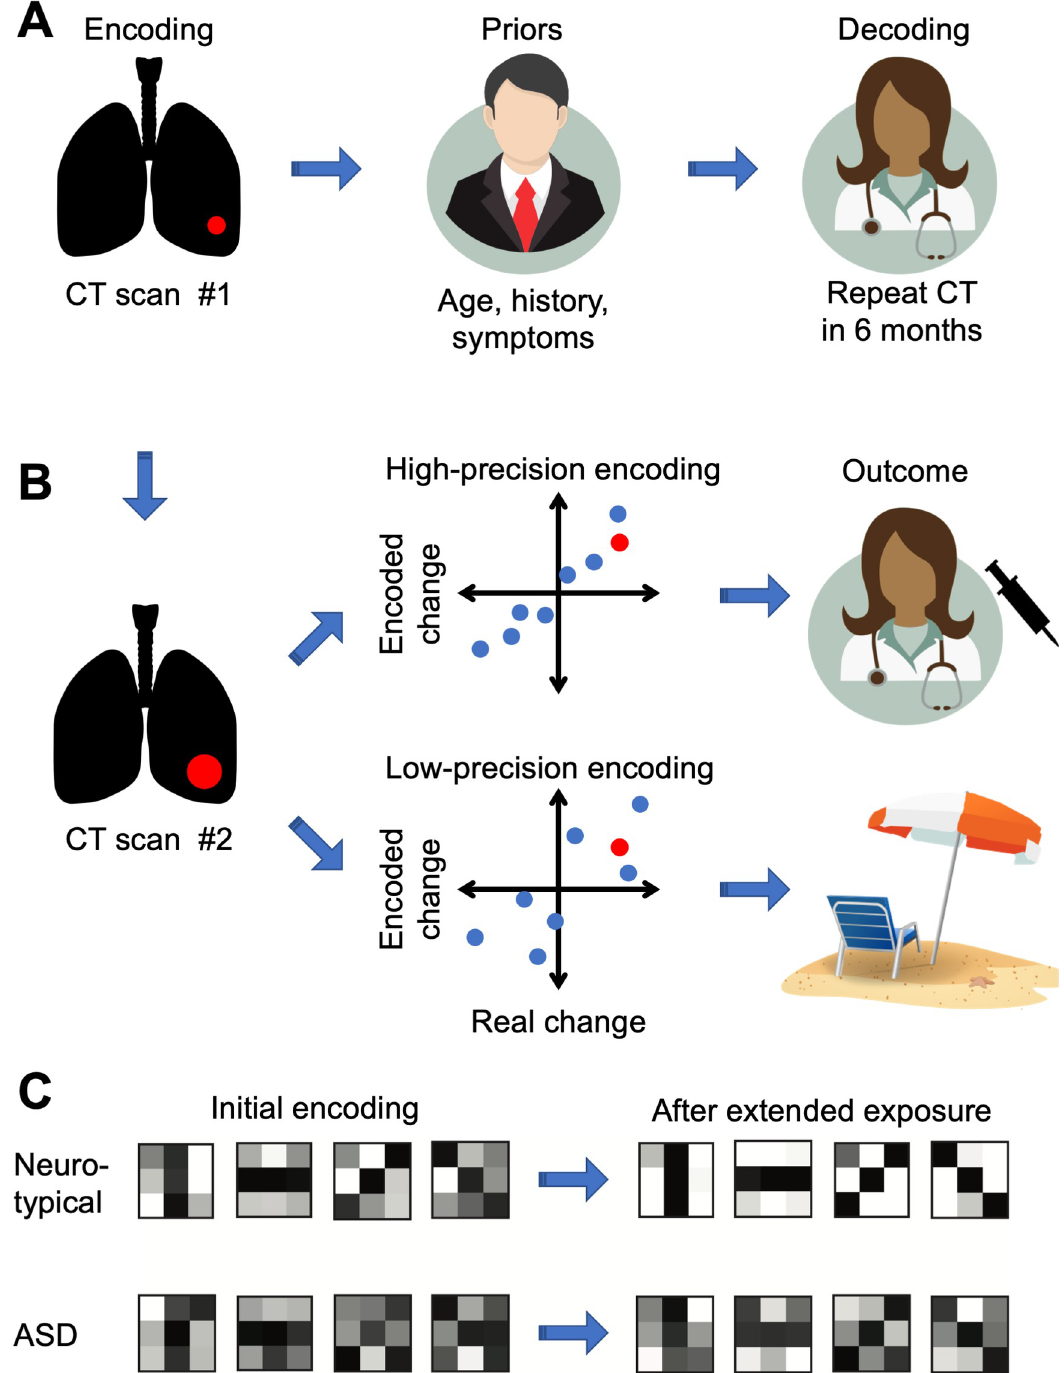
Fig 1. Perceptual encoding and decoding. (A) Medical imaging can be used as an analogy for perceptual encoding and decoding. Encoding is the mapping of sensory inputs onto neural representations, which, in our analogy, can be thought of a CT machine capturing an image of a lung mass. The interpretation of these images by a doctor illustrates perceptual decoding. Here, the doctor’s assessment is influenced by prior knowledge (e.g., patient’s background, age, and symptoms). Similarly, our perception is strongly influenced by our vast prior experience with our sensory environment. (B) In this analogy, the patient returns for a second CT. If the CT machine has high-precision encoding, then even a small increase in the measured size of the mass may suggest a significant change, and the doctor will order a biopsy. If the CT machine has low-precision encoding, then an equally small increase in the measured size of the mass may be within the margin of error, and the doctor may not order a biopsy. Similarly, high-precision